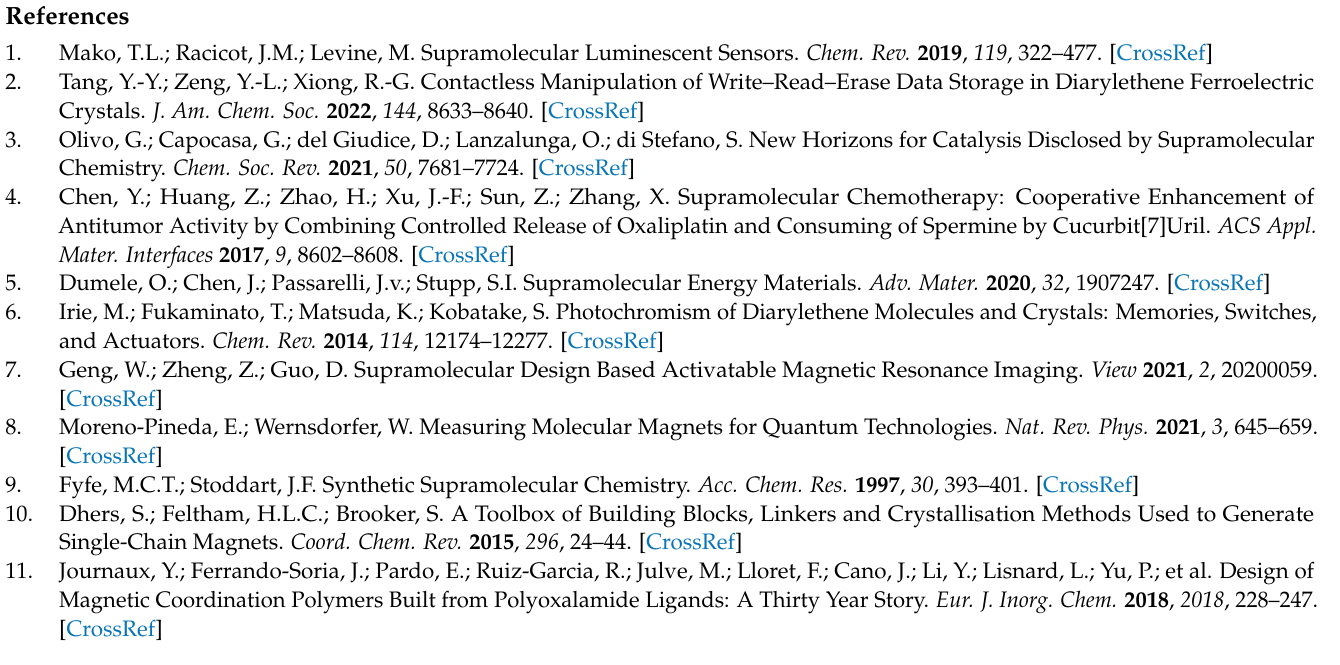
the illustration for clarity. Table S1: Crystal data and structure refinement for 1 ; Table S2: Bond lengths [Å] and angles [ ◦ ] for 1 ; Table S3: Hydrogen bond lengths [Å] and angles [ ◦ ] for 1 , where D and A are the donor and acceptor hydrogen atom, respectively; Table S4. Shape measurements analysis for 1